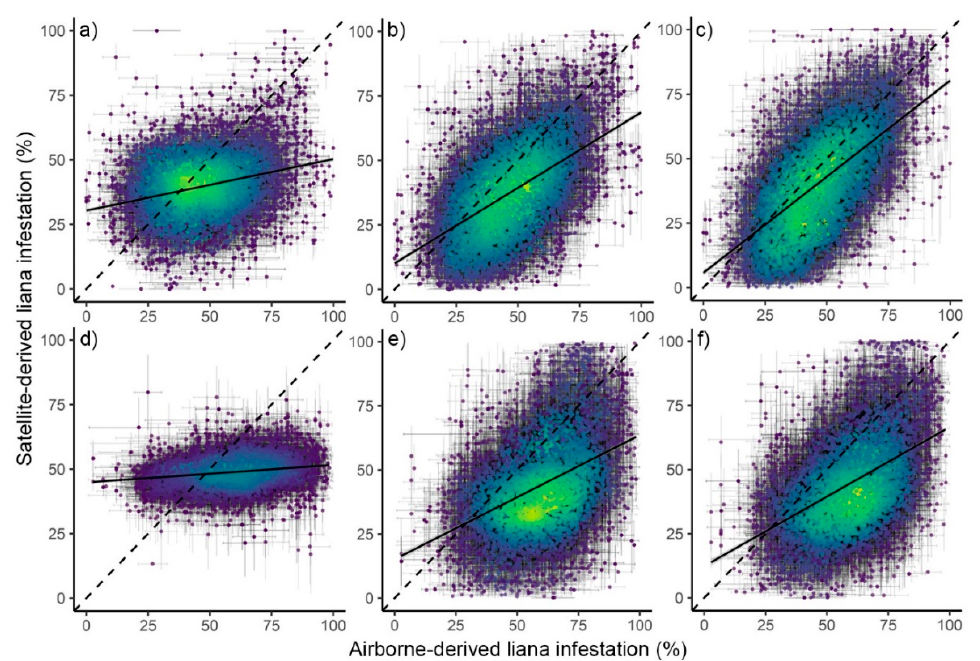
Figure 3. Relationship between airborne- and satellite-derived liana infestation with input variables consisting of ( a ) Greenness Index, ( b ) all Sentinel-2 bands and ( c ) Greenness Index and all Sentinel-2 bands in the primary forest and ( d ) Greenness Index, ( e ) all Sentinel-2 bands and ( f ) Greenness Index and all Sentinel-2 bands in the selectively logged forest. Dashed lines represent a 1:1 lines. Solid black lines correspond to linear models. Colored points correspond to the density of overlapping points ranging from purple to yellow with increasing density. Error bars represent ± 1 standard deviation.